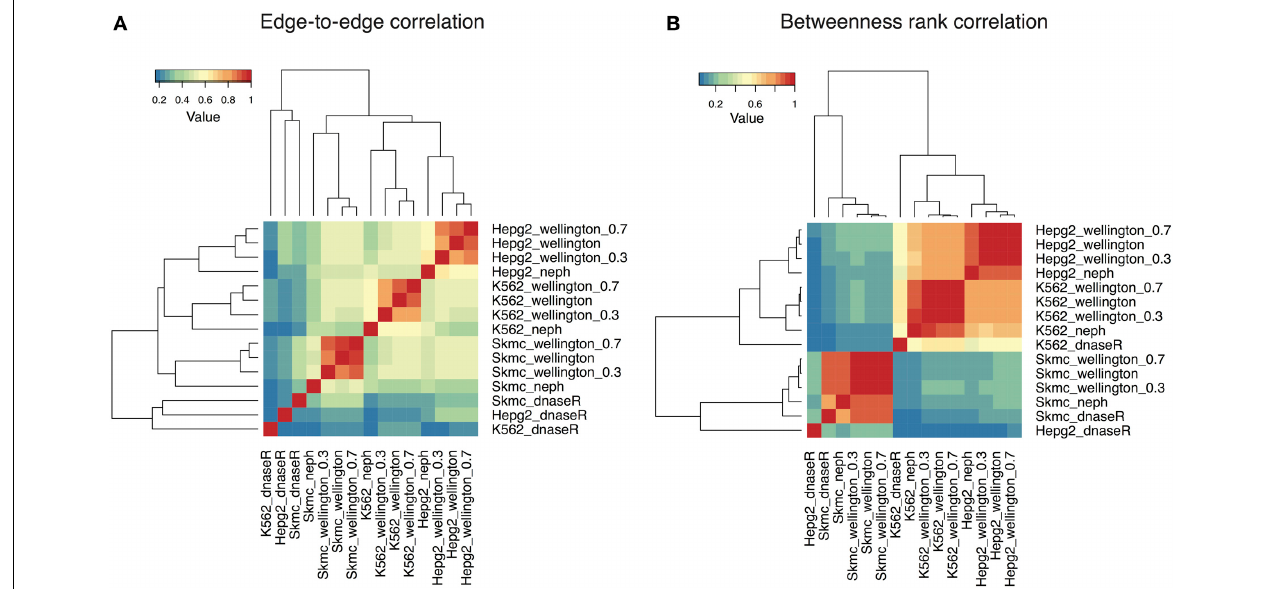
FIGURE 2 | Heatmaps summarizing the comparison among the TF-TF networks reconstructed with the sets of footprints obtained with DNaseR, Neph, Wellington in three different cell lines (K562, SkMC, HepG2). Networks obtained by running Wellington on 30 and 70% subsamples of aligned reads are also included. (A) Edge-to-edge correlation: DNaseR networks cluster separately; networks obtained with